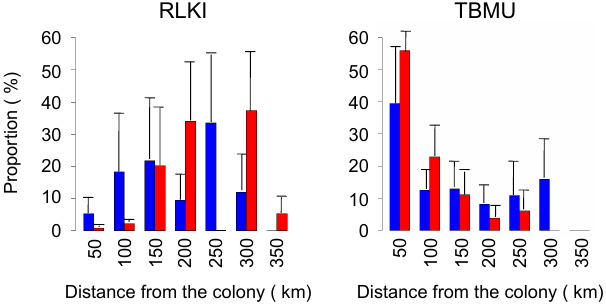
Figure 4. The mean and standard errors in plasma corticosterone concentrations of red-legged kittiwakes (RLKI) and thick-billed murres (TBMU) in 2013 (blue symbol) and 2014 (red